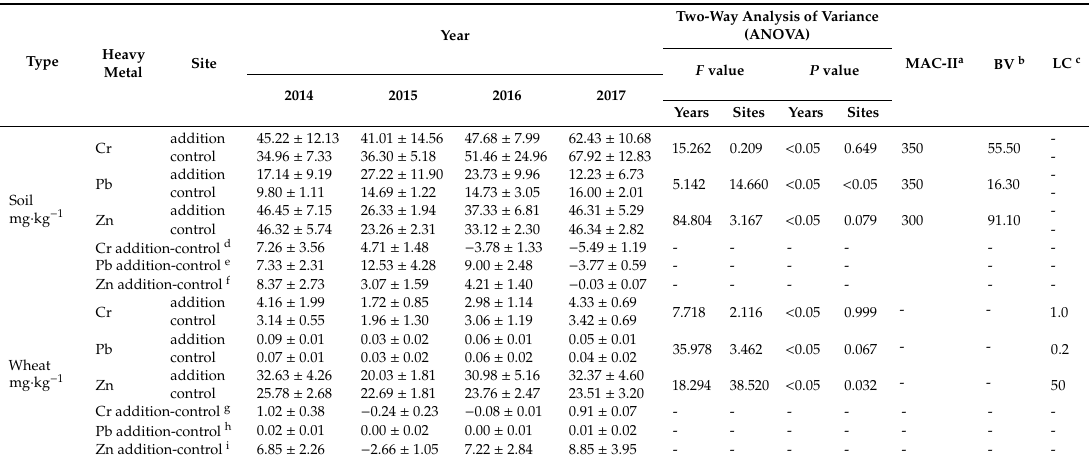
Table 2. Mean and standard deviation (SD) (mean ± SD) of heavy metal concentrations in soil and wheat from 2014 to